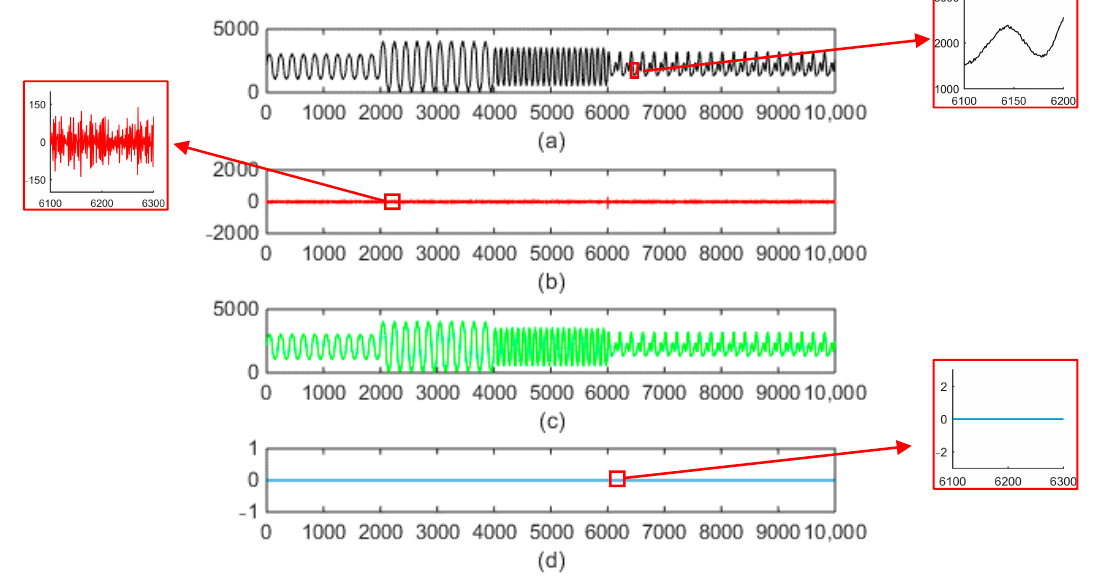
Figure 9. ( a ) The signals containing additive noise ( b ) Coding output ( c ) Decoding output ( d ) Error between the decoding output result and the original signal.